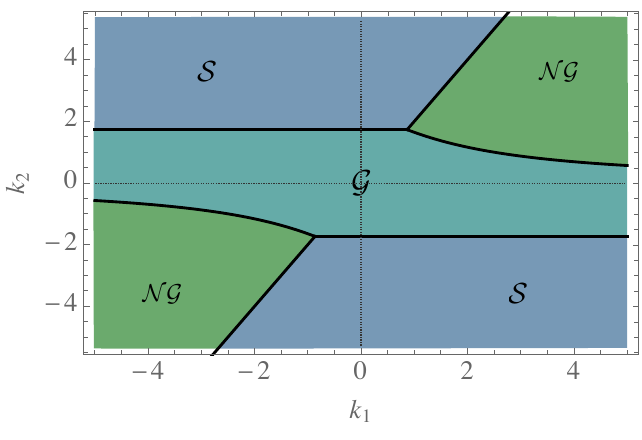
Figure 1 . Full stability diagram for ! b =